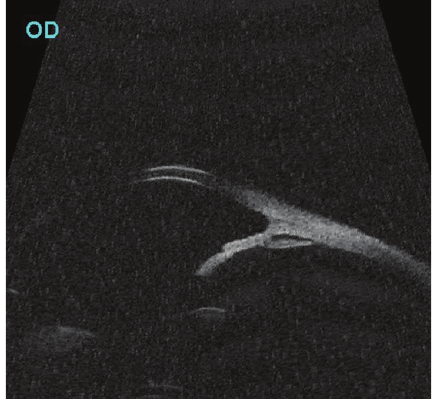
Figure 2: Radial section of ultrasound biomicroscopy showing insertion of ciliary processes on the posterior surface of iris and posterior bowing of iris.